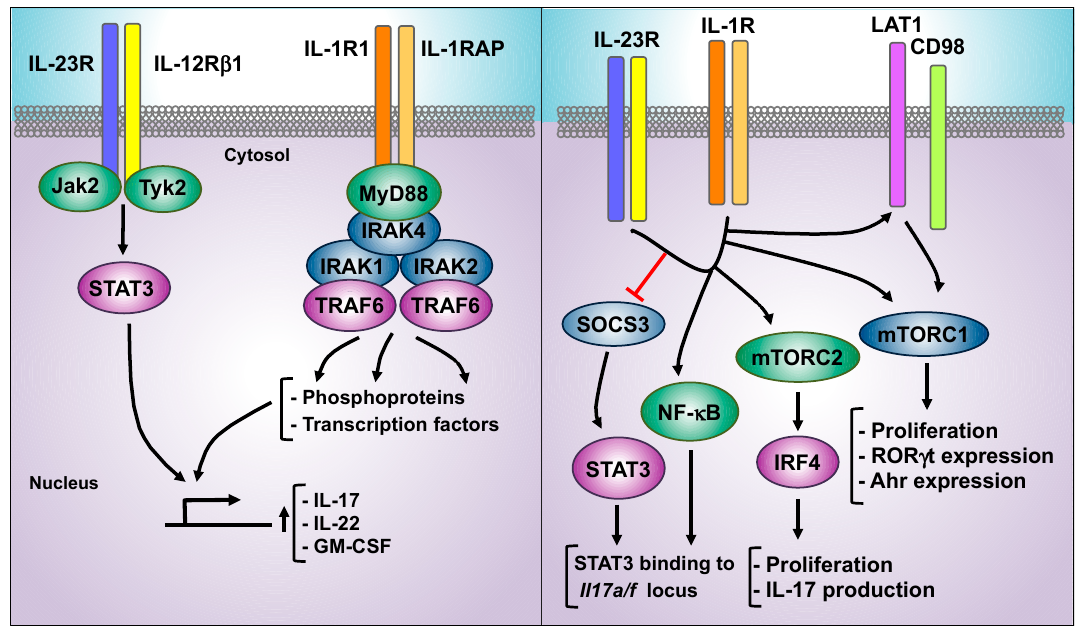
Figure 5. IL-23 and IL-1 β : signaling crosstalk. The combined action of IL-23 and IL-1 β greatly increases the production of IL-17, IL-22, and GM-CSF. Right , IL-23 and IL-1 β signaling cascades at a glance: IL-23 signaling cascade is mediated by the JAK / STAT module, while IL-1 β signal is transduced by MyD88 / IRAKs / TRAF6 module. MyD88 / IRAKs / TRAF6 induce the activation of several phosphoproteins and transcription factors. Left , IL-1 β stimulation decreases IL-23-induced expression of Socs3 in an NF- κ B-dependent manner, and decreased Socs3 expression upon IL-23 / IL-1 β stimulation leads to an increased STAT3 phosphorylation. IL-1 β -induced NF- κ B / RelA activation increased the binding of IL-23-induced STAT3 to regulatory elements in the Il17a / f locus. IL-23 and IL-1 β promote mTORC1 and mTORC2 activation. IL-23 / IL-1 β activation of mTORC2 induces the expression of the transcription factor IRF4, required for IL-17 production and T γδ cell proliferation. IL-23 / IL-1 β -induced mTORC1 activation promotes T γδ cell proliferation and induces ROR γ t and AhR expression in neutrophils. IL-23 / IL-1 β co-stimulation increases the expression of LAT1 and induces the activation of mTORC1 and the proliferation in T γδ 17